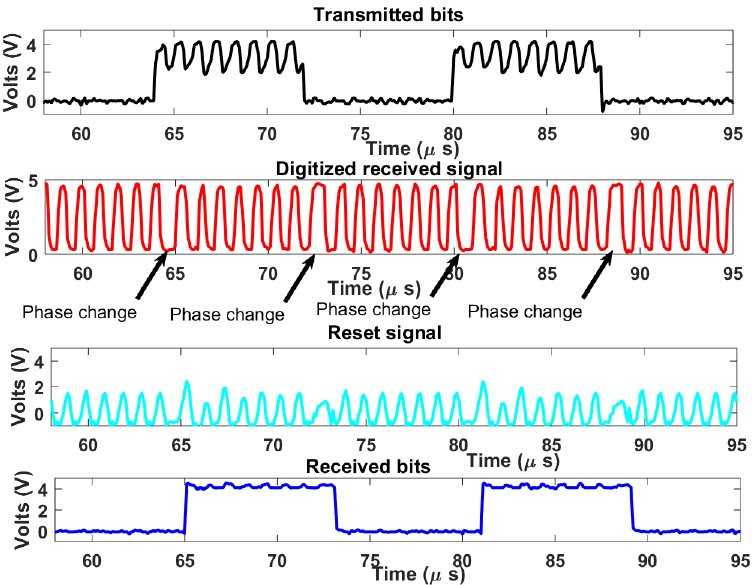
Figure 11. Measured signal